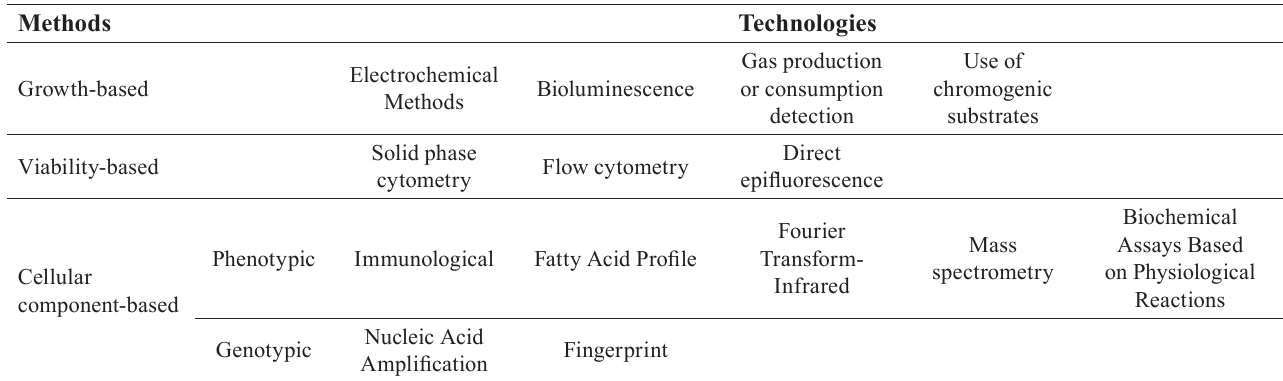
TABLE II - Main types of alternative microbiological methods and their respective technologies